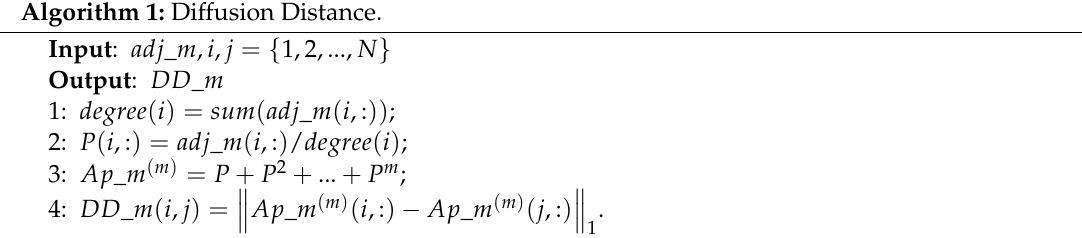
Algorithm 1: Diffusion